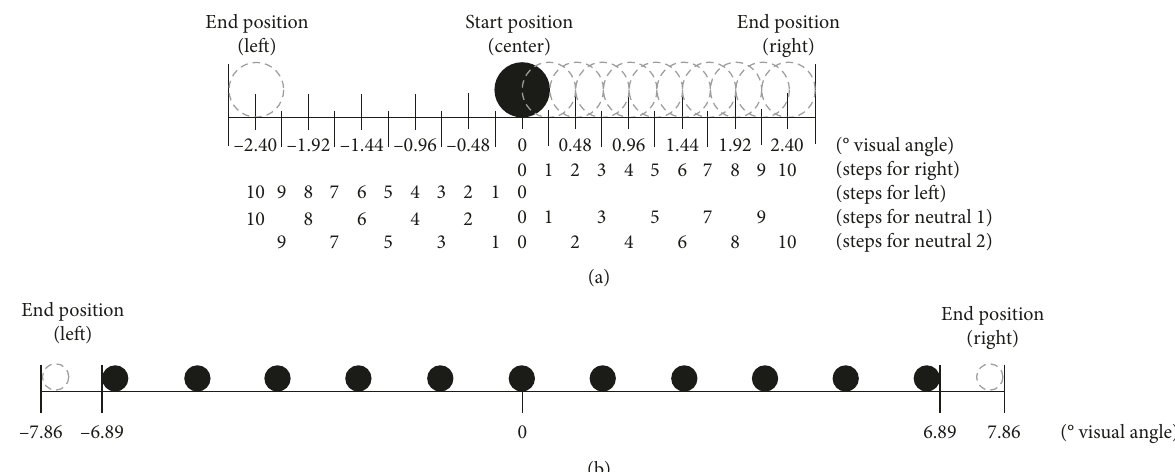
Figure 1: Prime stimuli used in the experiment. Black dots represent the original position of each prime at the center of the screen. Gray circles represent motion positions of the dot(s). For the case of a right moving single dot, all possible dot positions are depicted. The last gray circle on the left or right represents the end position of the motion for left or right movements. Each step lasted one refresh cycle (i.e., 13.33ms). Note that the scale for the single-dot motion type and the scale for the row-of-dots motion type differ. (a) Single-dot motion primes and (b) row-of-dots motion